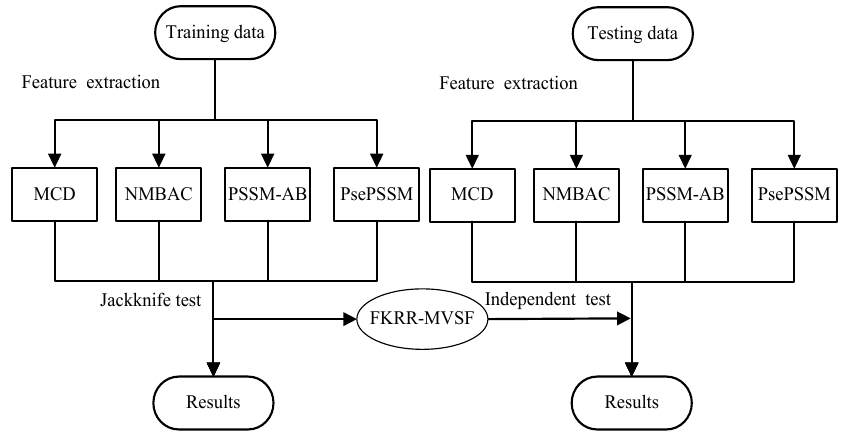
Figure 3. The process of DNA-binding protein